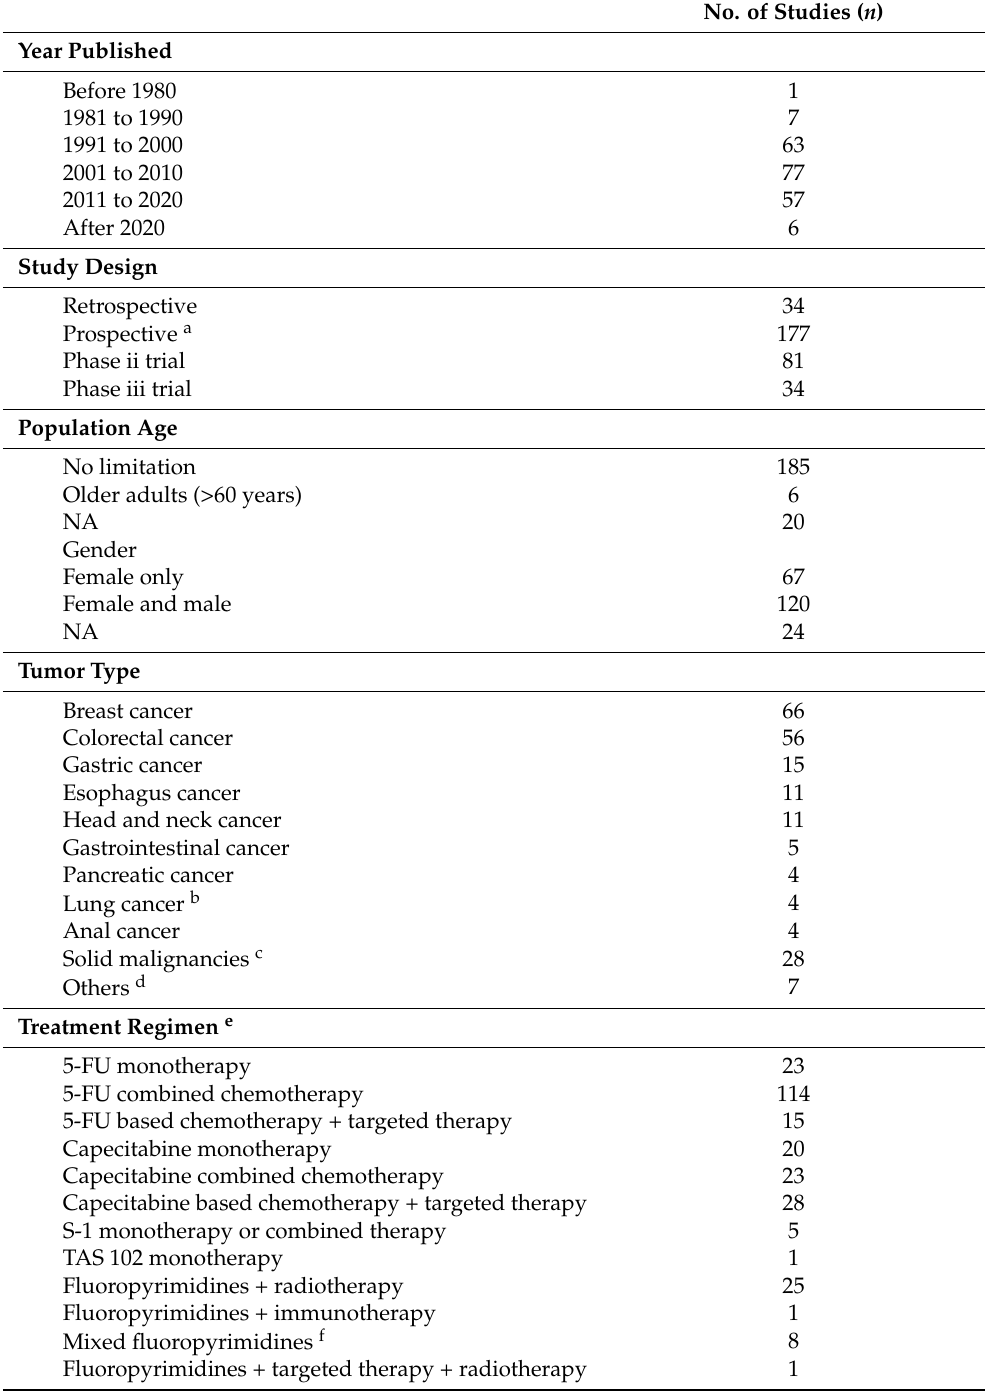
Table 1. Characteristics of the 206 studies included in this